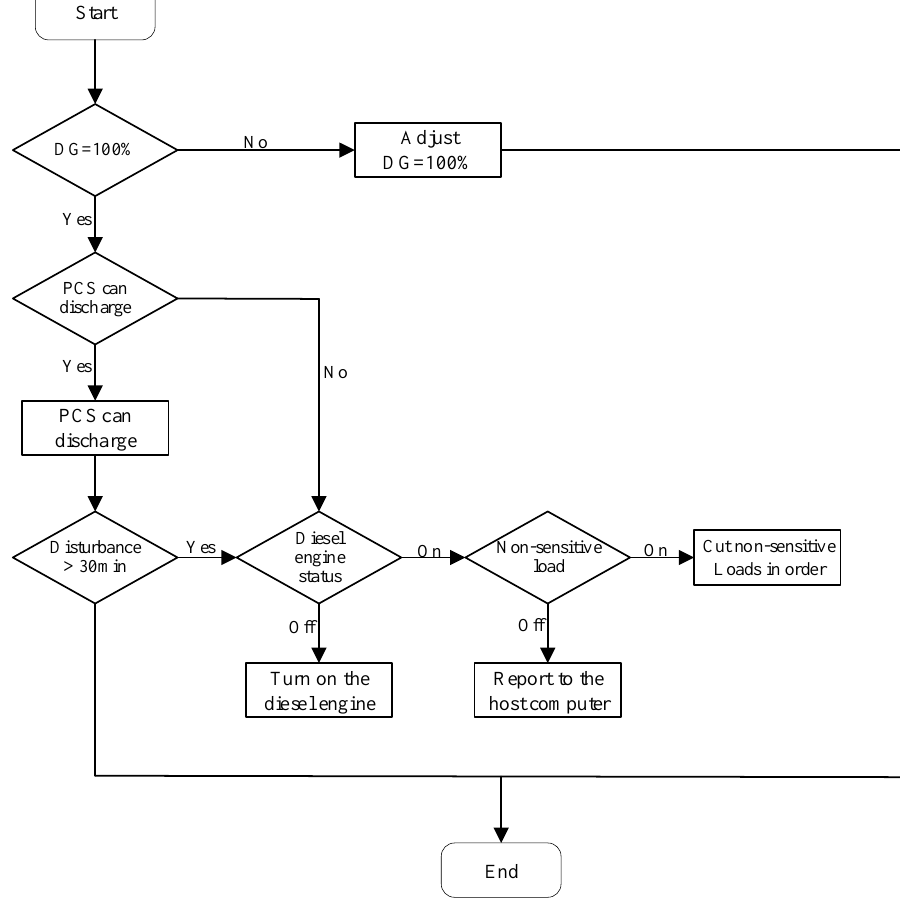
Figure 3. BL area frequency control strategy.